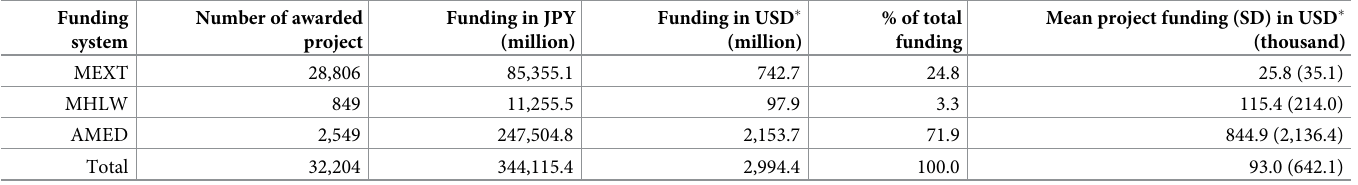
Table 2. Number of the awarded research project for 2015–2016 and amount of health R&D funding by the publicly competitive funding system.